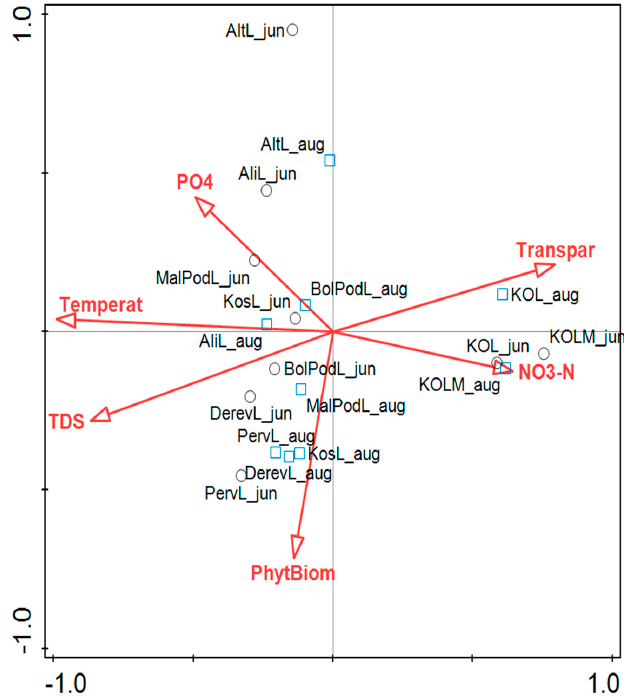
Figure 5. Redundancy Analysis, RDA results based on quantitative variables of zooplankton species. Circles—June, quadrangles—August, red arrows − environmental variables. Abbreviations used in the figure: AliL—Ali, PervL—Pervomaika, DerevL—Derevyannoe, AltL—Altynkol, KosL—Kosagash, MalPodL—Malaya Podkova, BolPodL—Bolshaya Podkova, KOL—Lower Kolsay, KOLM—Middle Kolsay.